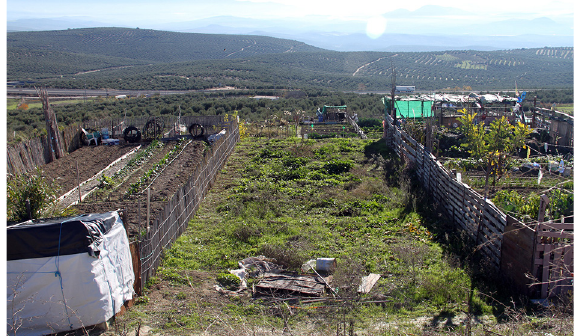
Fig. 6. Age structure of plots holders in 2014. Source: own elaboration based on data from the city office.